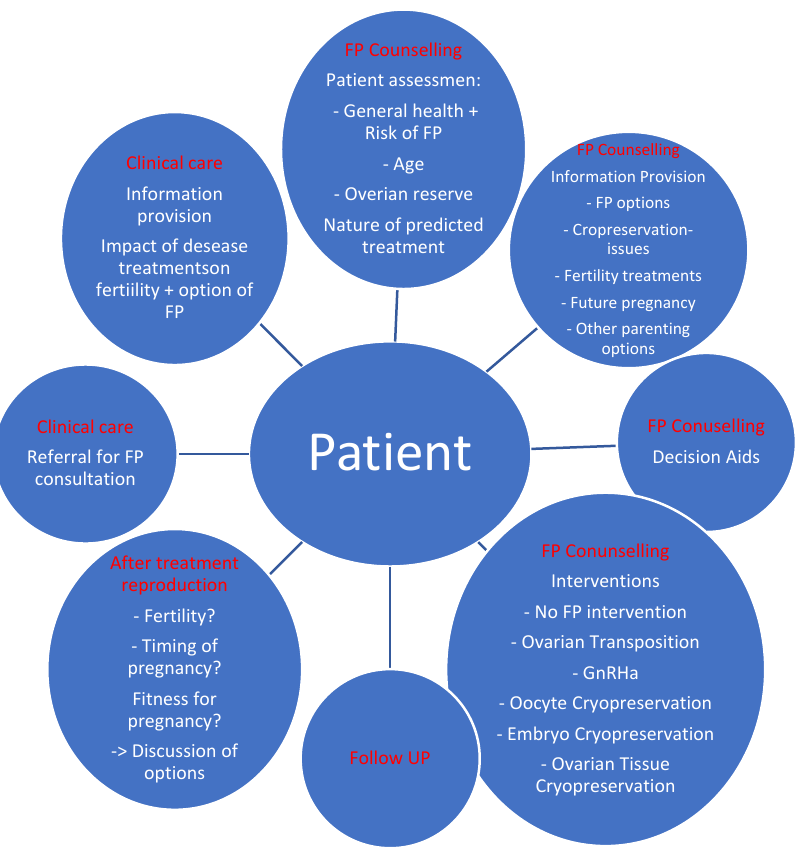
Figure 1. Model of care for patients eligible for fertility preservation.